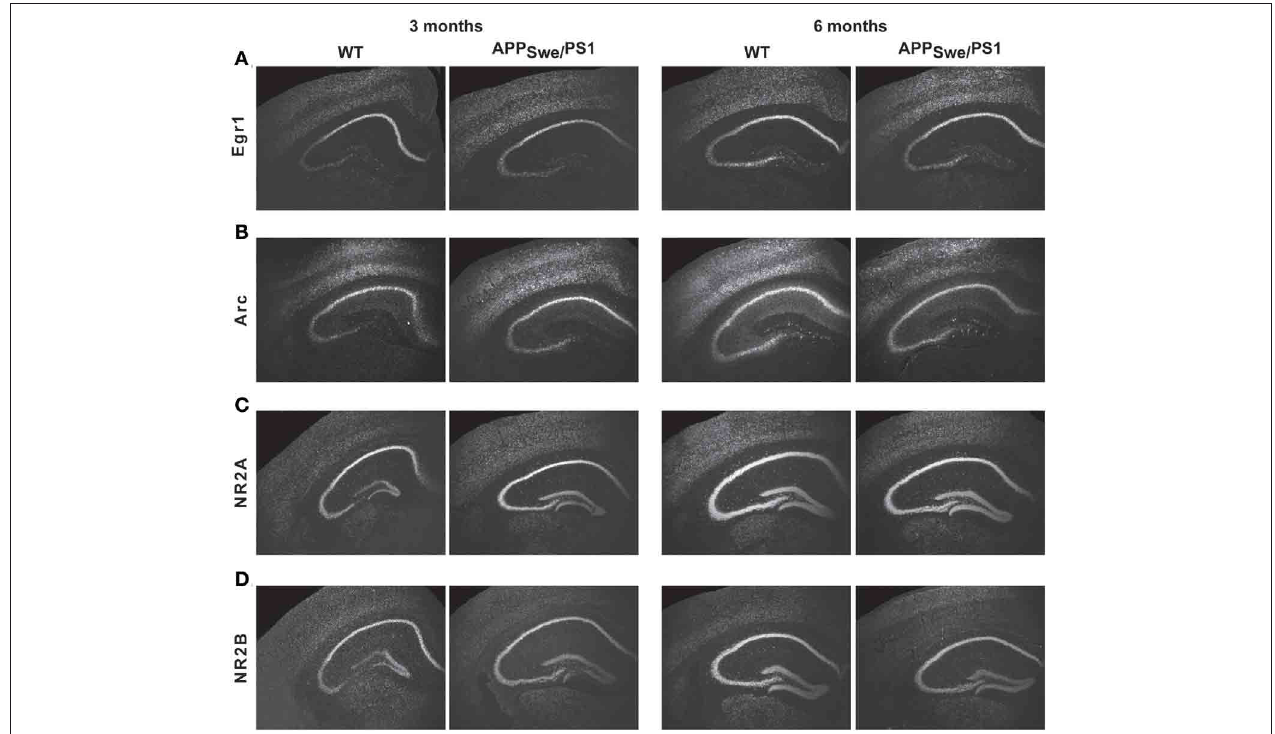
FIGURE 3 | Egr1, Arc, NR2A, and NR2B transcript levels in APP Swe /PS1 mice. Expression of Egr1, Arc, PSD95, AMPA1, NR2A, and NR2B mRNA were determined by in situ hybridization. Three-month-old WT and APP Swe /PS1 mice had similar mRNA levels of Egr1